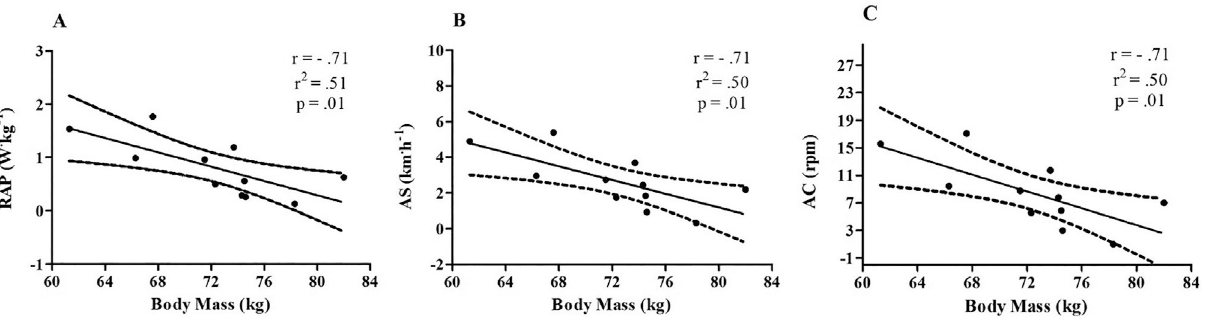
Figure 1 - Coefficient of the correlation between body mass (kg) and delta ( Δ ) of the variables relative to the average power (RAP) (W · kg -1 ) (Figure 1A), average speed (AS) (km · h -1 ) (Figure 1B), and average cadence (AV) (rpm) (Figure